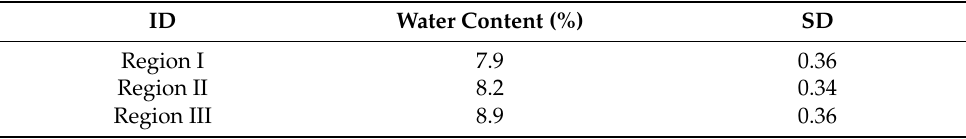
Figure 11. Water capillary absorption of giant reeds from different regions as a function of the square root of test time. Table 8. Water content of giant reeds from different Portuguese